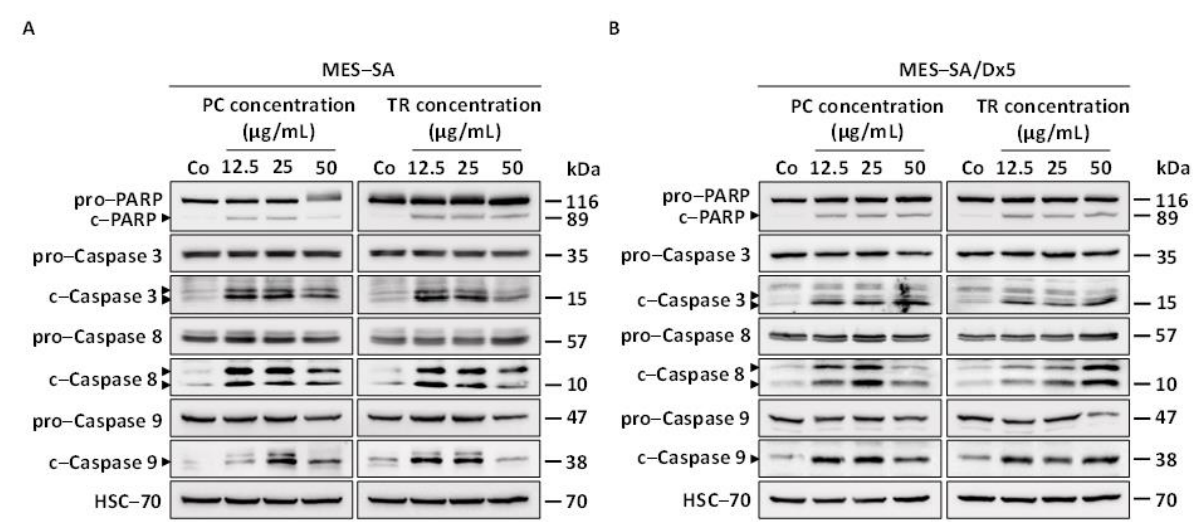
Figure 7. Pituranthos chloranthus (PC) and Teucrium ramosissimum Desf. (TR) extracts activate key players of the intrinsic apoptotic pathway in MES-SA and MES-SA/Dx5 cells. ( A , B ) Immunoblot analysis of pro and cleaved forms of Poly(ADP- ribose)-polymerase (PARP), caspases 3, 8, and 9 after 72 h of treatment with vehicle (dimethyl sulfoxide, DMSO; Control, Co) or the indicated concentrations of PC and TR in MES-SA ( A ) and MES-SA/Dx5 ( B ) cells. Heat shock cognate 70 (HSC-70) was used as the loading control. A representative blot from three independent experiments is shown.